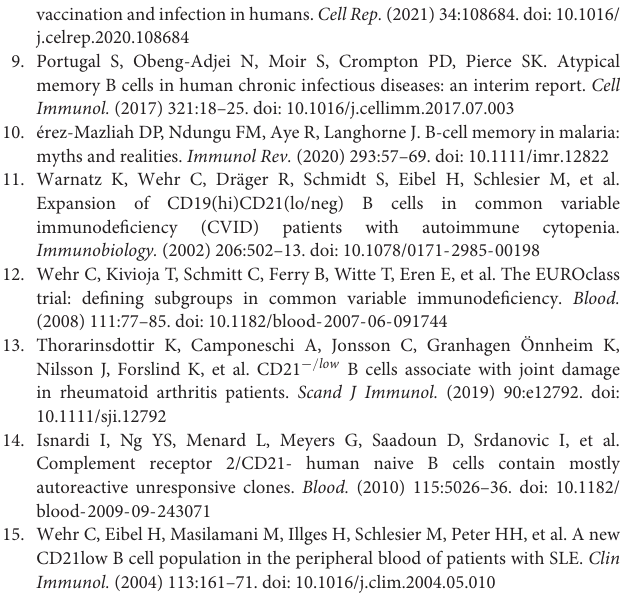
Supplementary Figure 1 | Age-related B-cell subset percentages in study and healthy cohorts. (A) Box plots showing B-cell subsets (transitional, naïve, memory, activated memory, atypical B cells, and plasmablasts) in the study cohort divided in ten different age ranges ( < 1 y: n = 126; 1–2 y: n = 246; 3–4 y: n = 226; 5–6 y: n = 198; 7–8 y: n = 156; 9–10 y: n = 160; 11–12 y: n = 132; 13–14 y: n = 128; 15–16 y: n = 130; 17–18 y: n = 68). Boxes are shown with median, lower and upper limits (first and third quartiles, respectively). Whiskers indicate lower quartile − 1.5 × IQR (interquartile range) and upper quartile + 1.5 × IQR. Outliers are shown as dots. (B) Matrices for statistical test significance representation among age ranges for each B-cell subset in the study cohort. Each matrix reports significance for two distinct B-cell subsets. Statistical significance was determined using Kruskal–Wallis test with adjusted p -value at 0.000556. Supplementary Figure 2 | atBCs features in the study cohort. (A) Box plot comparison of IgM or IgD Mean Fluorescence Intensity (MFI) values, within IgM + -only or IgD + -only subpopulations, between atBC and MBC subsets. Only samples with atBCs > 5% are represented. (B) Distribution by box plots of IgM and IgD expressing B cells within the CD24 + atBC subset in those samples in the study cohort with atBCs > 5%. Statistical significances were determined using unpaired two-tailed Mann–Whitney U -tests or Kruskal–Wallis test with adjusted p -value at 0.004167, ∗∗∗ p < 0.001; ### p < 0.004167. Supplementary Figure 3 | atBCs percentages at first (T0) and second (T1) flow cytometric assessment. Before-after graph showing changes of atBCs percentages at two sampling time points. Statistical significance was determined using Wilcoxon matched-pairs signed rank test. Supplementary Figure 4 | Identification of immunoglobulin isotypes in selected pediatric disorders. Scatter dot plots indicating the percentages of CD24 + , IgM + IgD + , IgM + -only, IgD + -only, IgM − IgD − , IgG + atBCs in selected disorders in patients with increased atBCs ( > 5%). Red bars indicate medians. Supplementary Table 1 | atBCs increase groups and associated diseases. Tables showing specific diseases and number of observations in each group of increased atBCs (low, medium, and